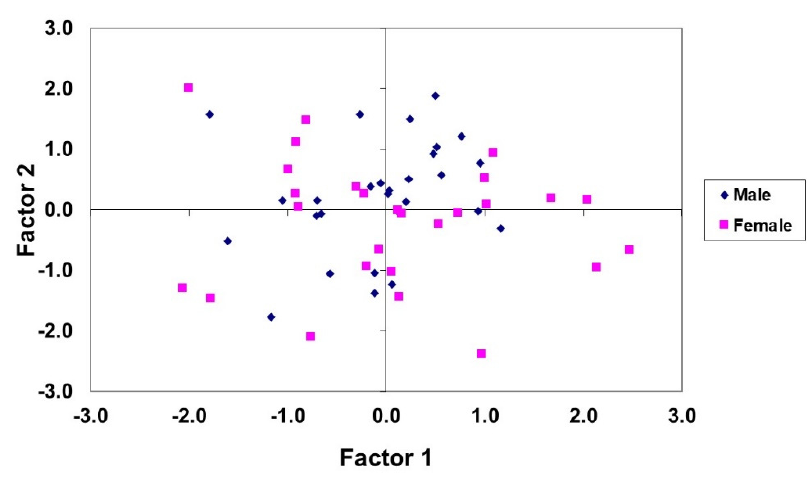
Figure 4. Projection of the sensory quality data of the male and female groups studied in the plane defined by the two principal components.